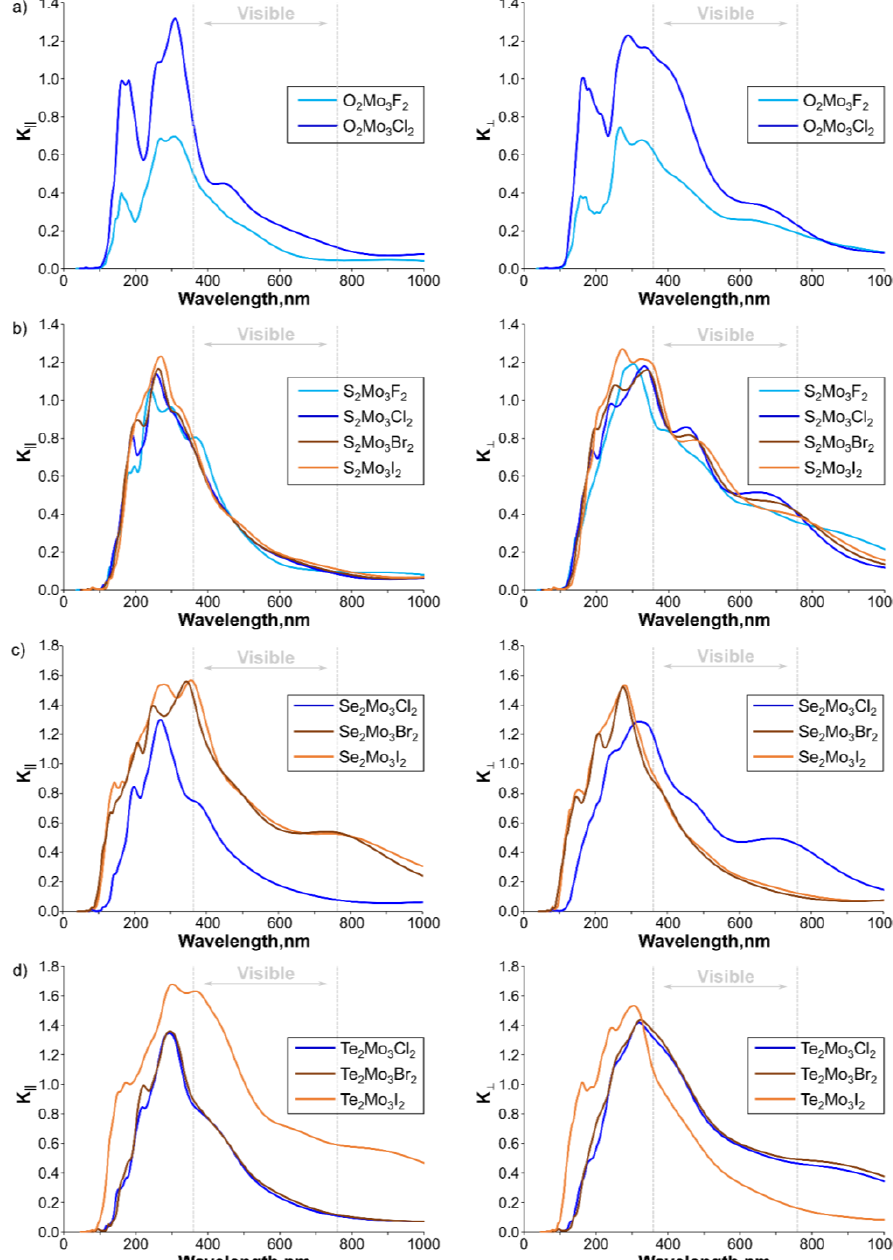
Figure 7. Wavelength dependence of the extinction coefficient in the transverse direction and per- pendicular to the surface for dynamically stable Janus Ch 2 Mo 3 Hal 2 Chevrel phases (Ch = O, S, Se, Te; Hal = F, Cl, Br, I): ( a ) oxygen-, ( b ) sulfur-, ( c ) selenium-, and ( d ) tellurium-containing monolay-